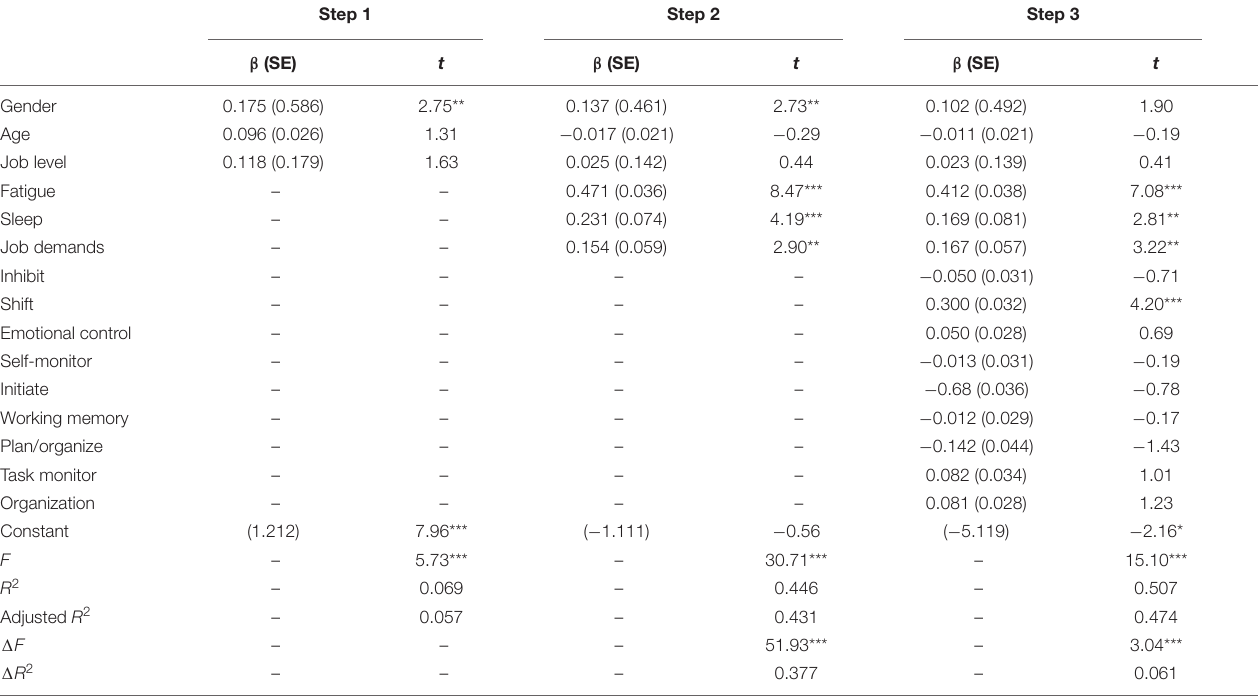
TABLE 4 | Multiple regression results for predicting work-related affective